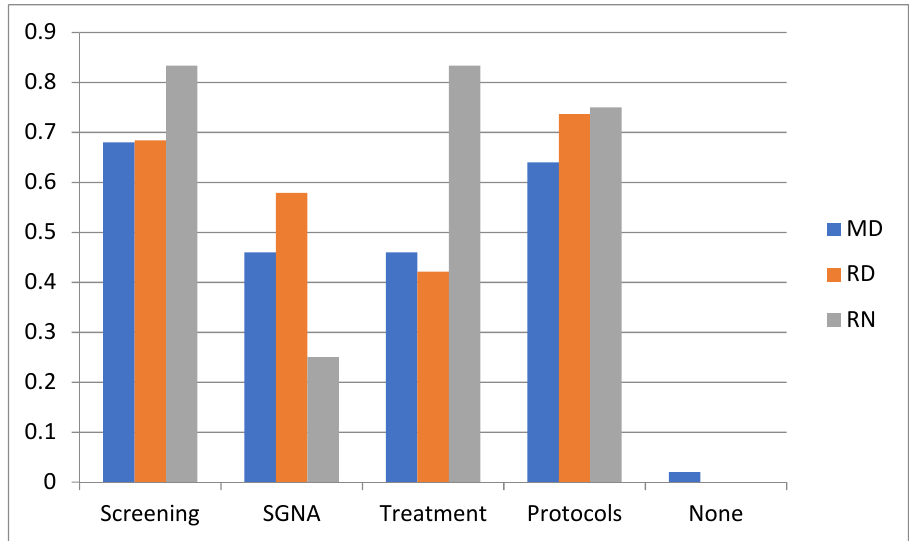
Figure 3. Interests in further nutrition-related education in Canadian tertiary hospitals by health care profession. RN: registered nurses, RD: registered dietitians; MD: medical doctors; SGNA: Subjective Global Nutritional Assessment; results expressed as a proportion of the respondents for this question ( n = 42).